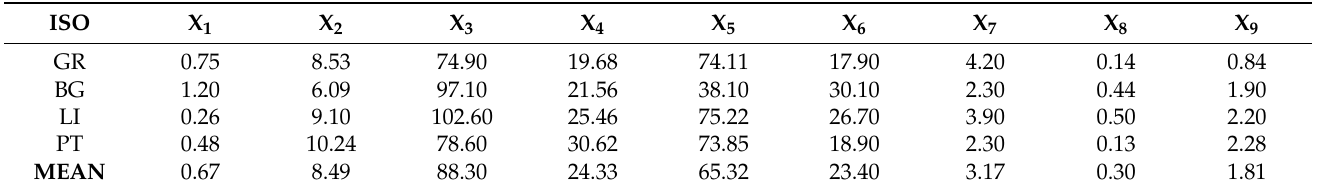
Table 7. “Smart and efficient energy systems”—values of diagnostic variables for countries constitut- ing cluster 4.